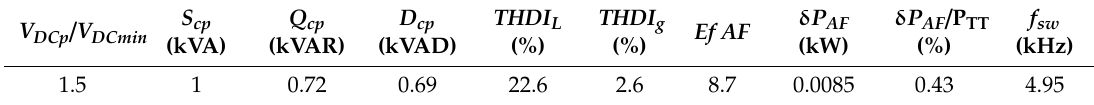
Table 6. The main experimental energetic performances of the adaptive control, at reduced load. V DCp / V